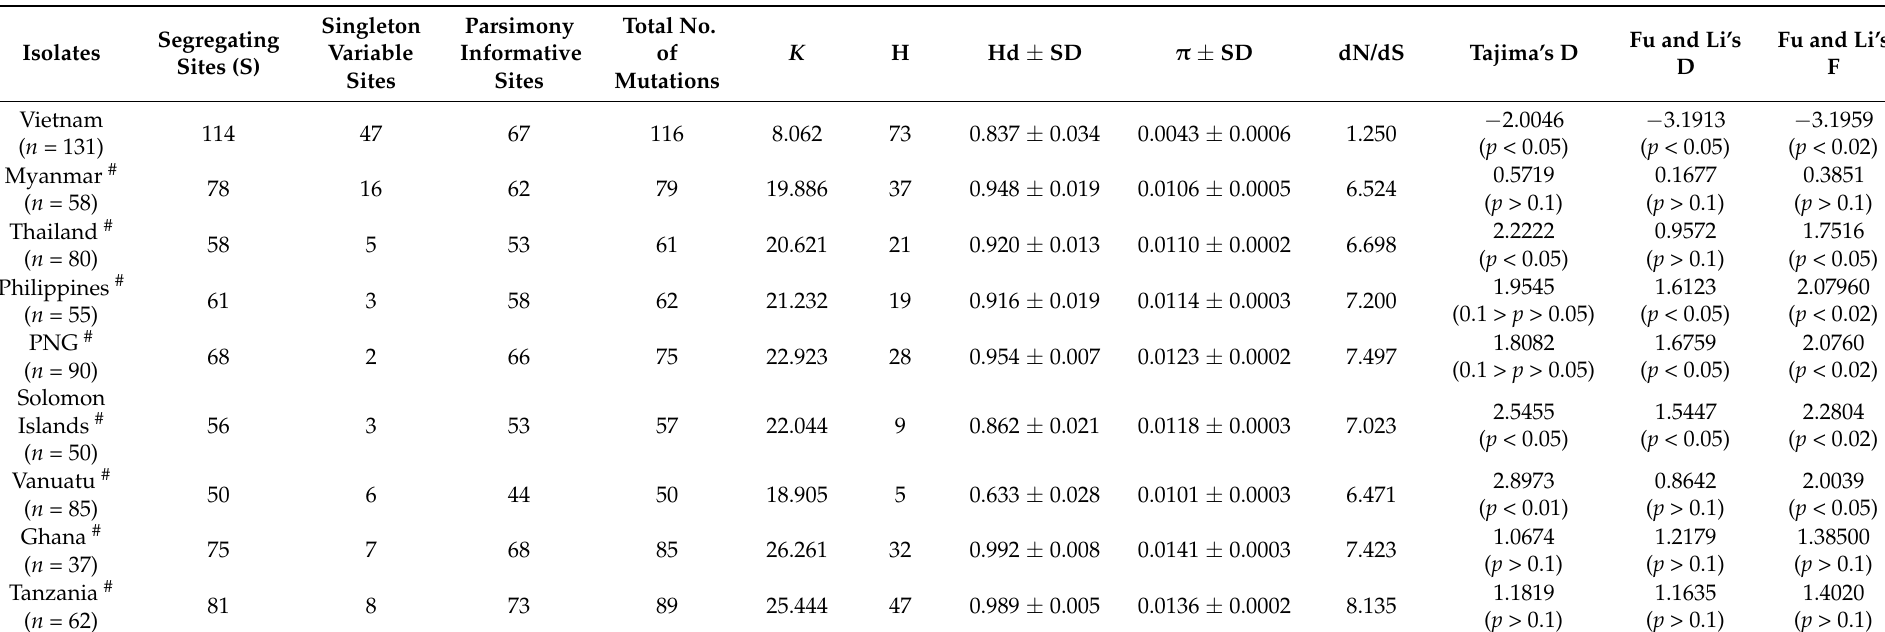
Table 2. Estimates of DNA sequence polymorphism and tests of neutrality at pfama-1 among global P.